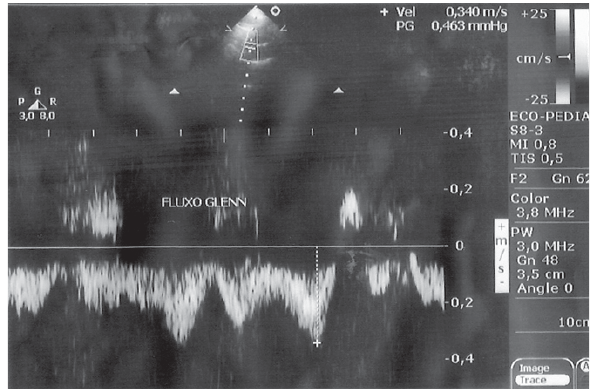
Fig. 2 – Traçado de Doppler pulsado com amostra localizada na anastomose entre a veia cava superior e artéria pulmonar direita, com velocidade de pico de 0,34 m/s